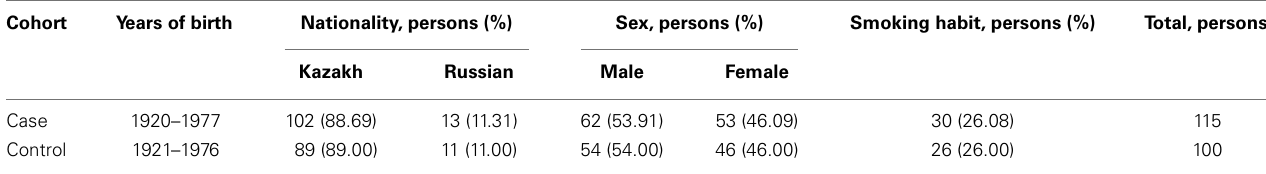
Table 2 |The correspondence of the esophageal cancer case and control cohorts by age, ethnicity, sex, and smoking habit.